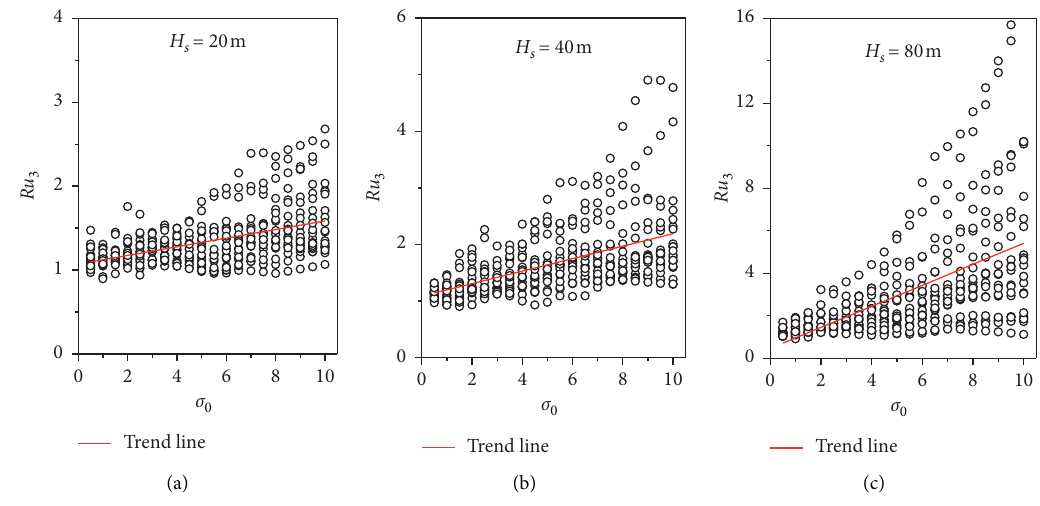
Figure 22: The parameters Ru